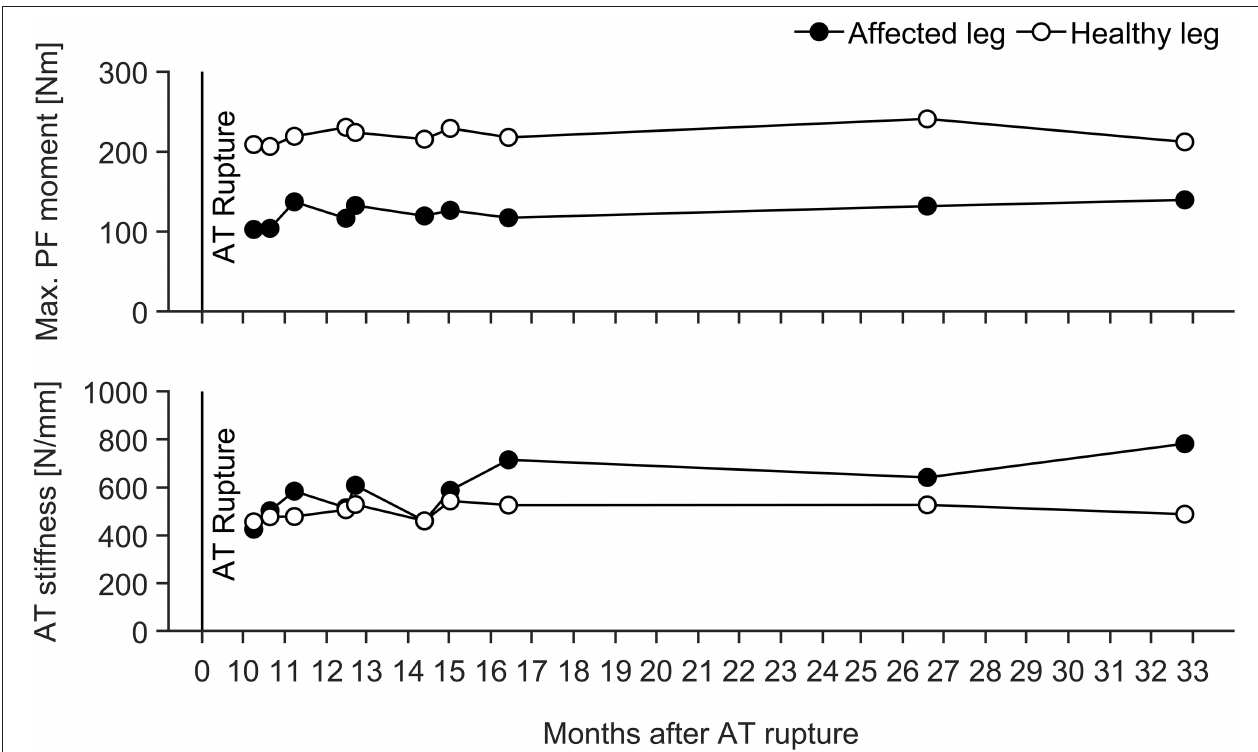
FIGURE 6 | Adaptive changes in TS muscle strength (Max. PF moment) and tendon stiffness (AT stiffness) in the affected and healthy leg of an elite athlete with an Achilles tendon rupture and reconstruction during a follow up time period of 2 years. Maximal tendon strain ranged from 1.5 to 2.5% and from 3.9 to 4.9% for the affected and healthy leg over the entire observation window,